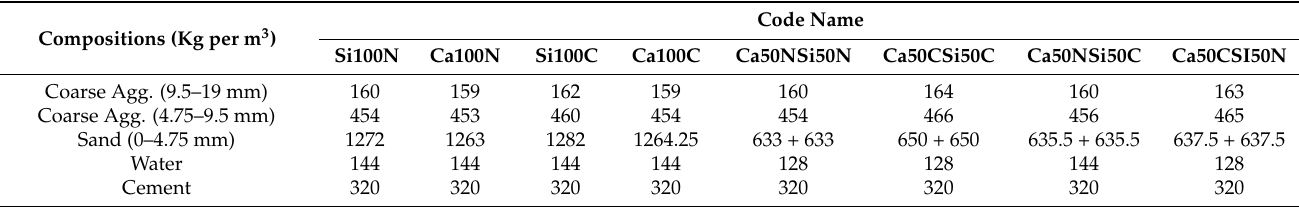
Table 5. Mix proportions per one cubic meter of RCC.